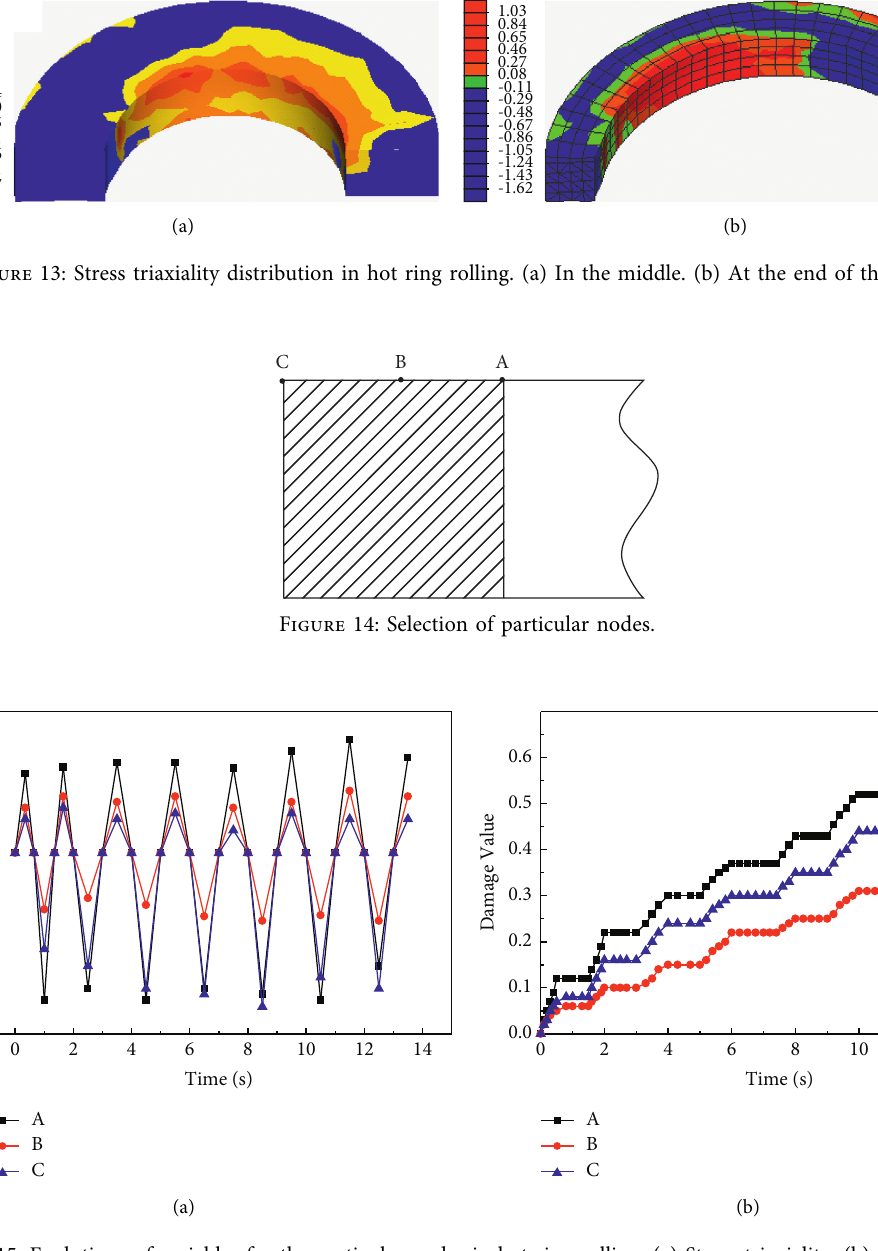
Figure 15: Evolutions of variables for the particular nodes in hot ring rolling. (a) Stress triaxiality. (b) Damage value.